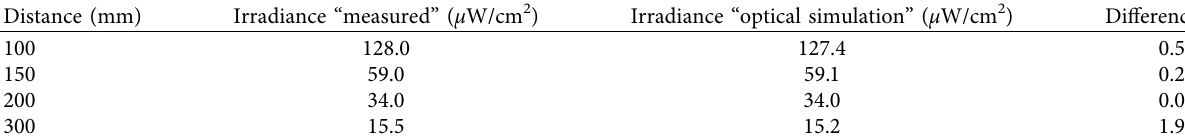
Table 2: Comparison of optical simulations with the measurements.